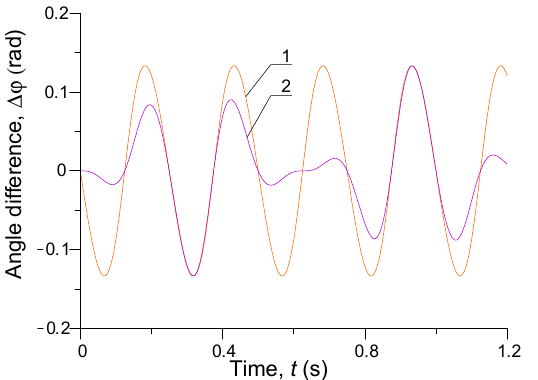
Figure 6. Waveforms of rotation angle differences between the first and third shafts for the angles α 1,2 and α 2,3 constant and variable in time: 1—the angles constant in time α 1,2 ≠ α 2,3 and 2—the angles variable in time α ( t ) 1,2 ≠ α ( t ) 2,3 .